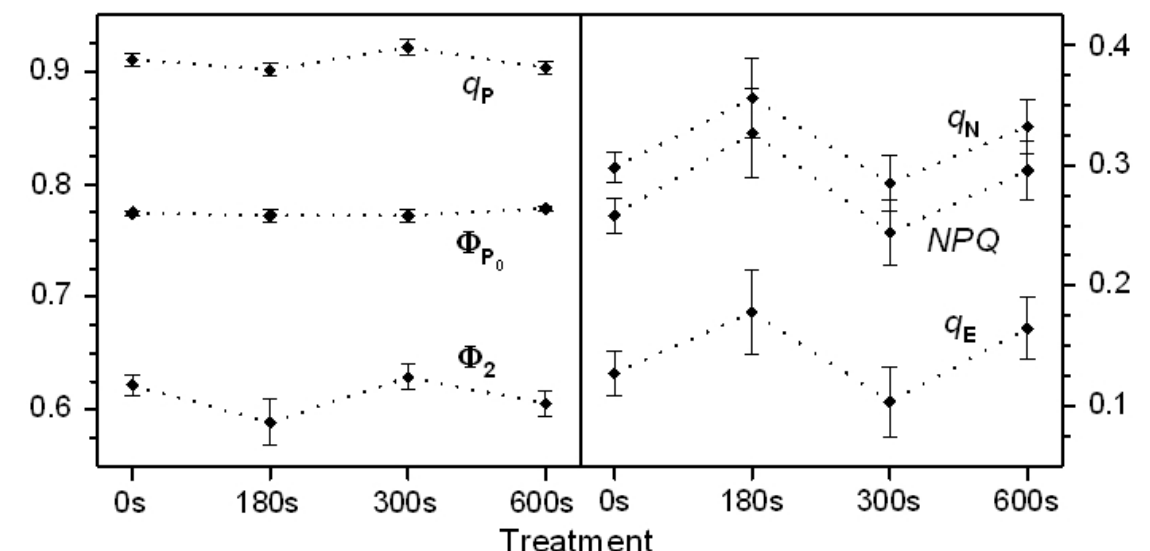
Figure 2. The photochemical ( left ) and non-photochemical ( right ) parameters evaluated on young maize plants dependent on the duration of the NTP treatment: q P —the actual fraction of open reaction centers of PS2, Φ Po —the maximum photochemical capacity of PS2, Φ 2 —the actual efficiency of photochemical conversion of radiant energy in PS2, q N —the non-photochemical quenching of variable fluorescence, NPQ—the non-photochemical quenching linked to dissipation of excitation energy to heat, q E —the efficiency of pH-gradient formation. Trends shown in dotted